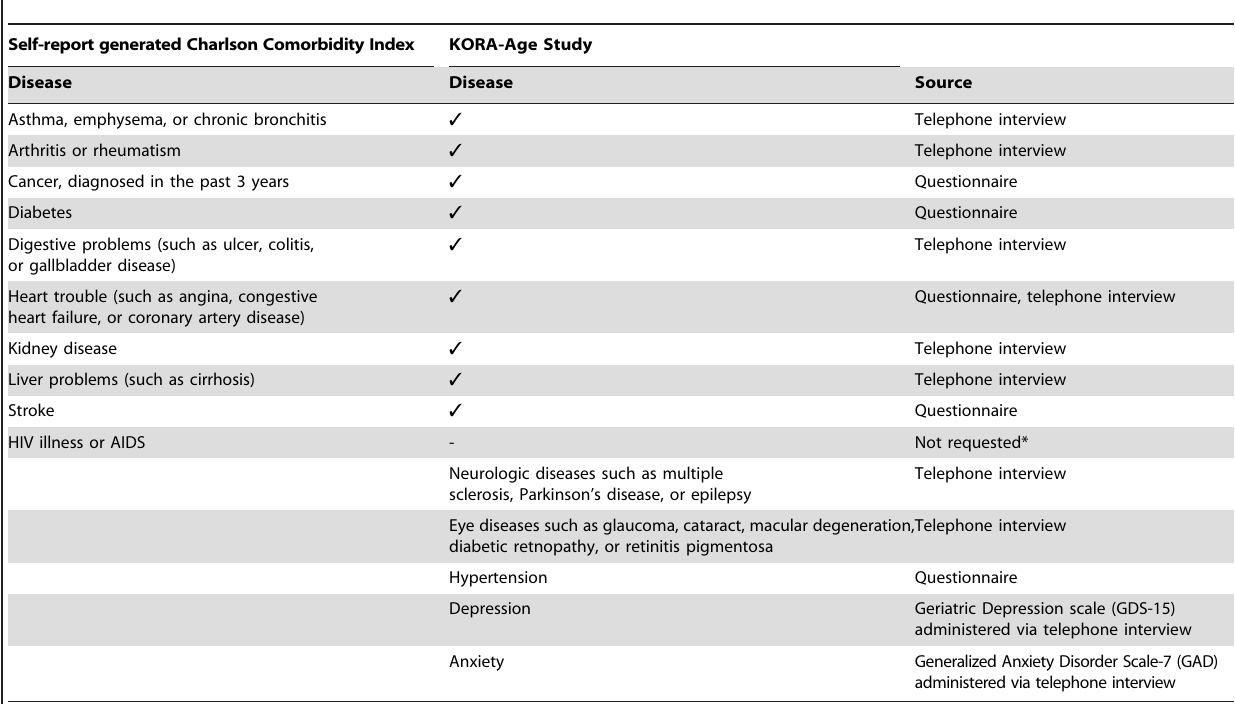
Table 1. Assessment of diseases in the KORA-Age